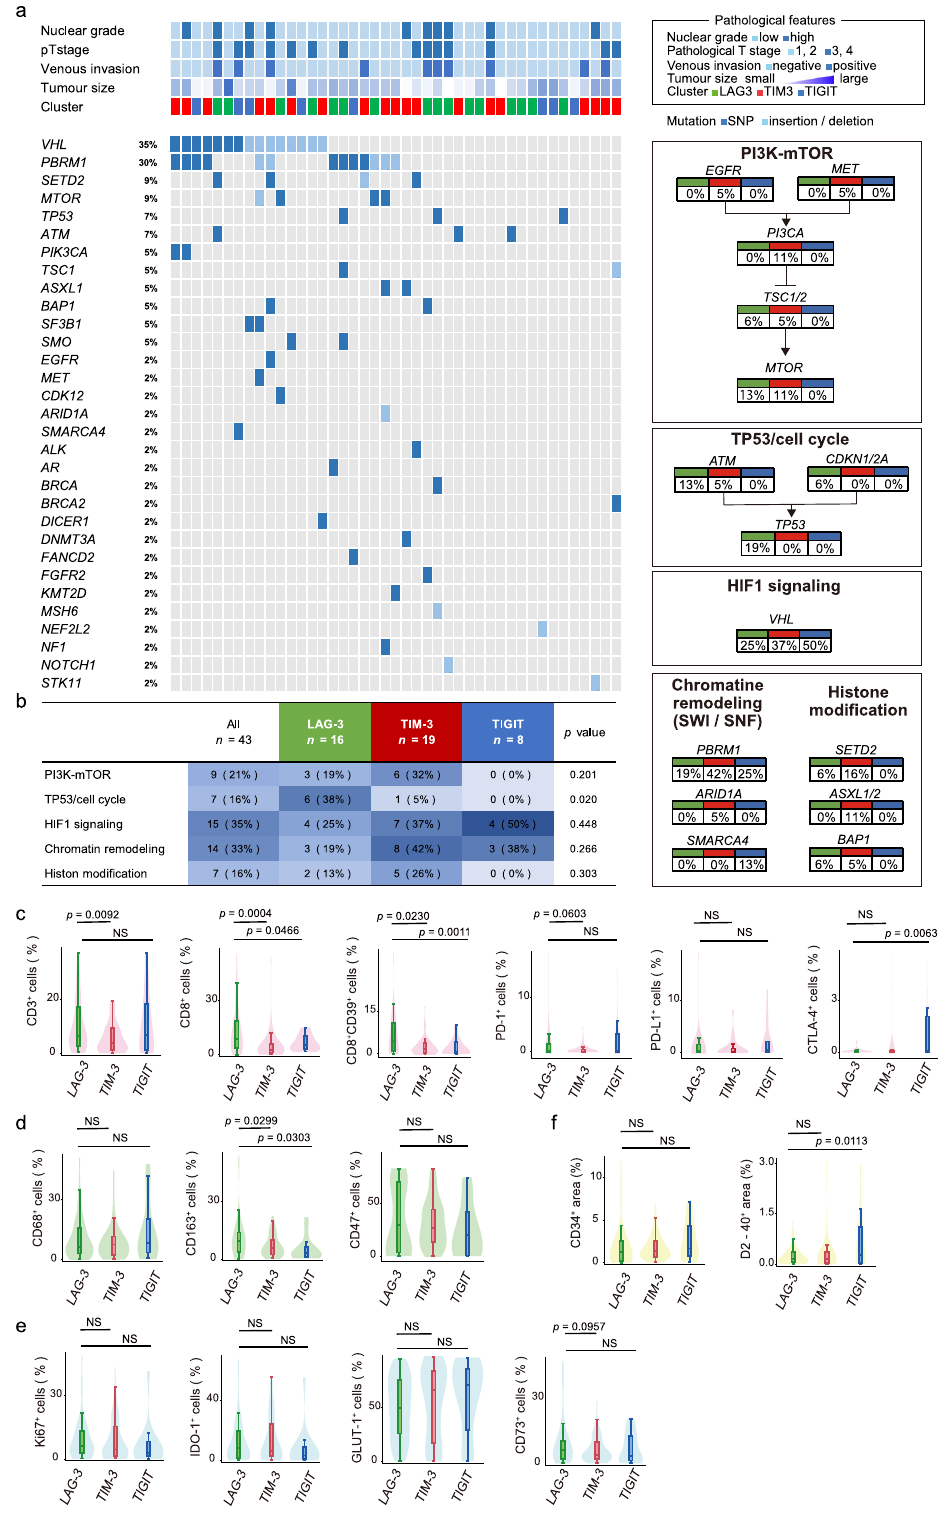
positive cell densities identi fi ed three groups with distinct IR levels. TIM-3 (47%), LAG-3 (30%) and TIGIT (23%) were individually dominant in independent clusters (Fig. 3a). Since no signi fi cant association was revealed on statistical analysis between the IR pro fi le patterns and the metastatic regions (Supplementary Table 2), regional heterogeneity added another layer of complex- ity to the second series of IRs (LAG-3, TIM-3, and TIGIT) in